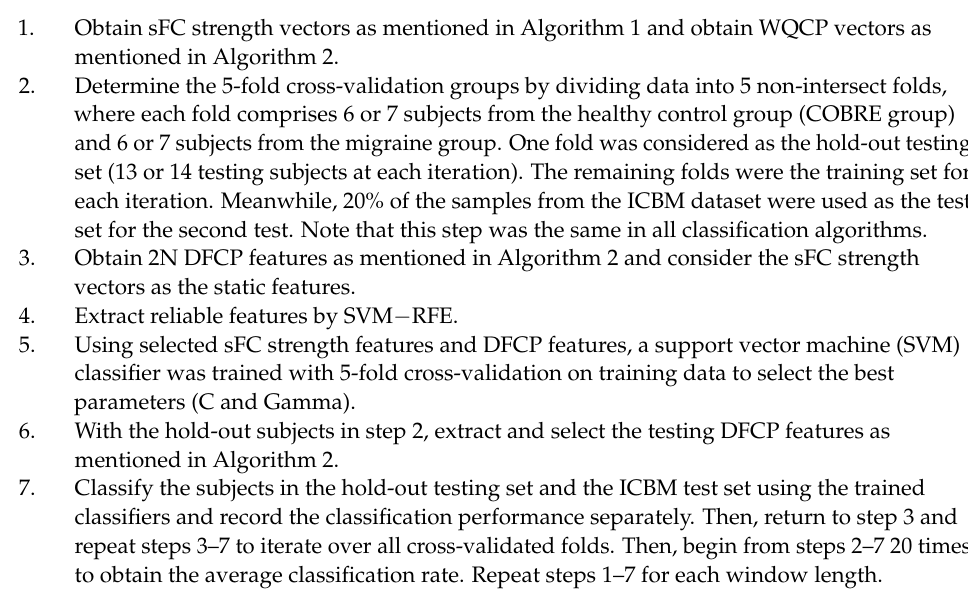
Algorithm 3 : classification based on combined the sFC strength and DFCPs